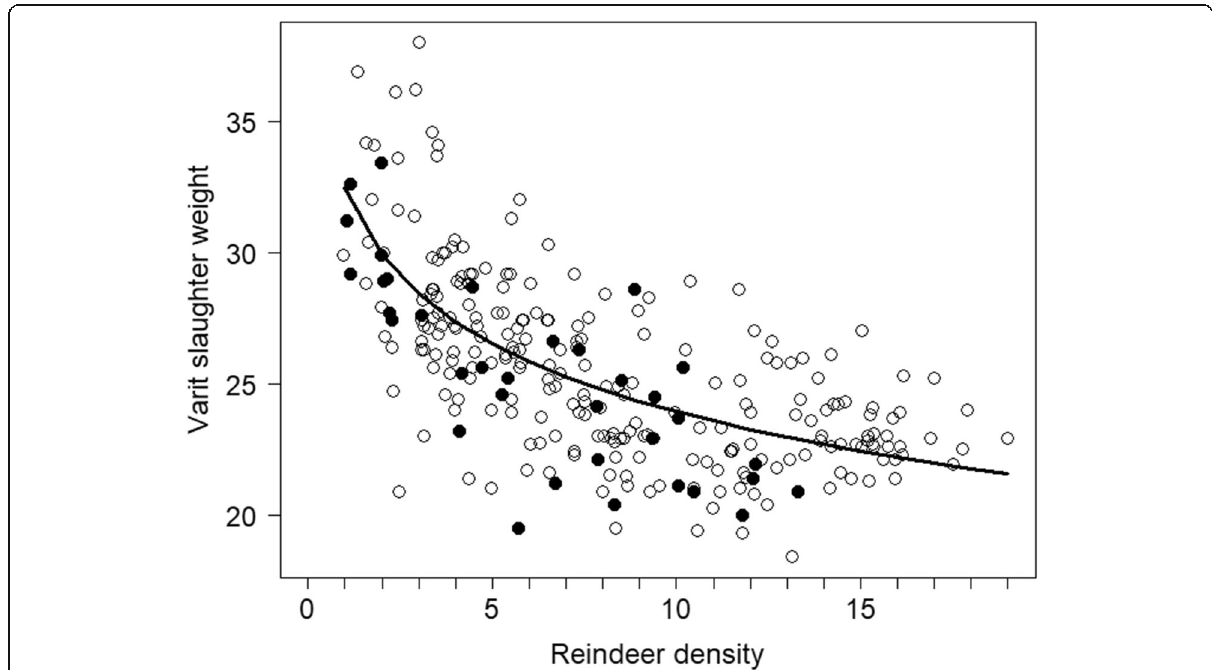
Fig. 1 Estimates of average varit slaughter weights (kg) plotted against district-level summer population densities (km − 2 ). Filled circles are estimates from the years used by Ims and Kosmo (2001, slaughter data from autumns of 1998 – 2000), and open circles are for the subsequent years up to 2019 and 1997/1998. The line gives the best fit linear regression line with log(density) fitted as a predictor variable (estimated regression coefficients: intercept = 32.41, SE = 0.47, ln(density) slope = − 3.71, SE =